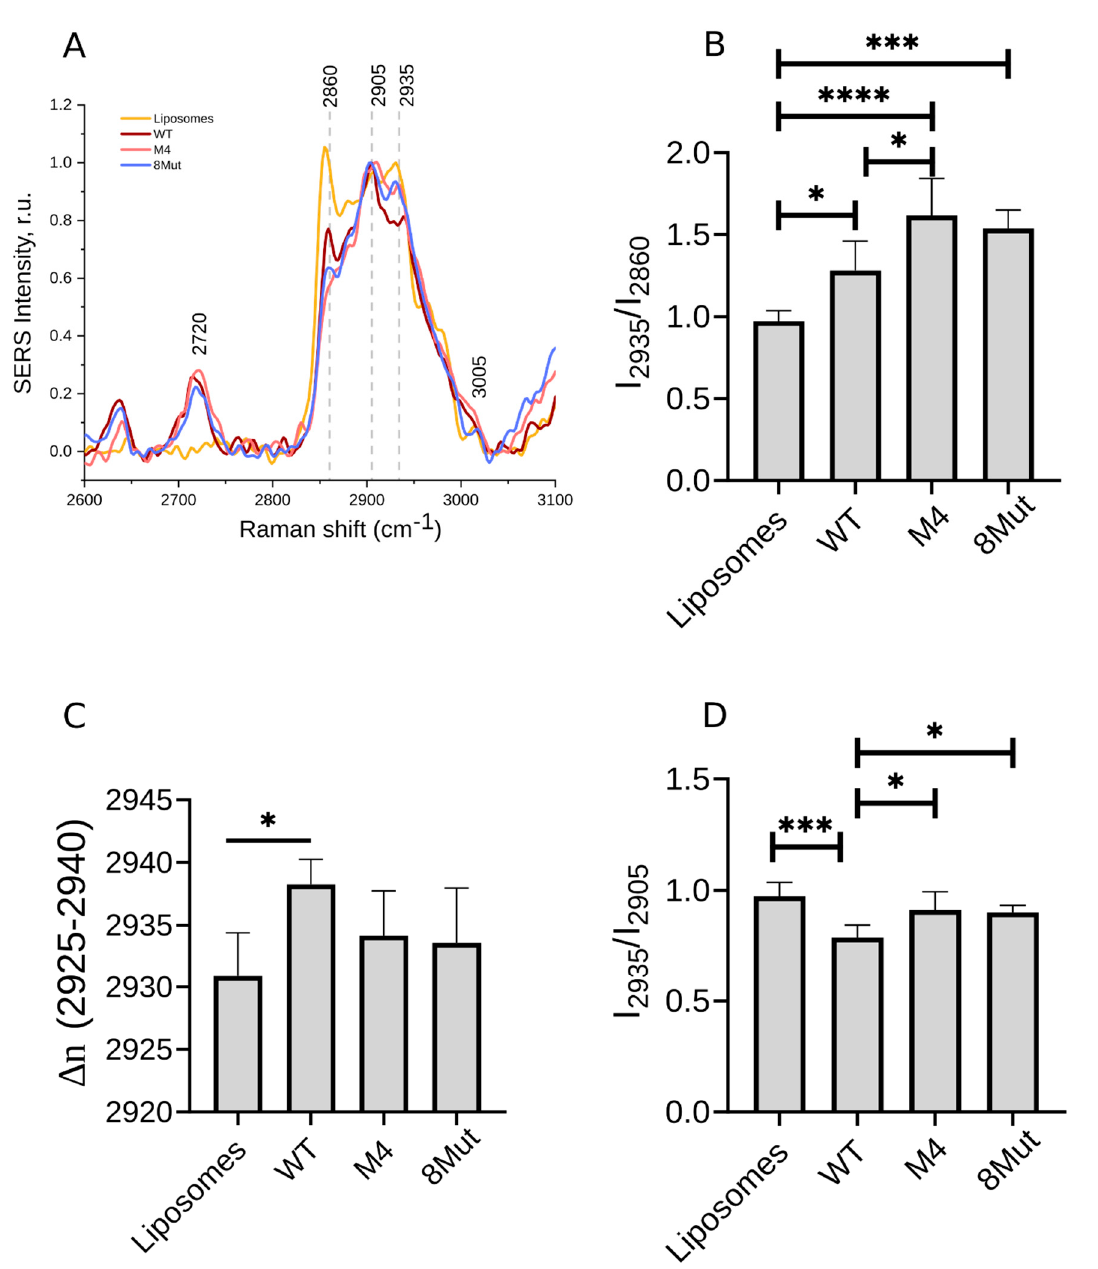
Figure 6. ( A ) Typical SERS spectra of control liposomes (PC:CL = 4:1) and liposomes with added cytochromes, normalized to the intensity of the peak 2905 cm − 1 . ( B ) The relative input of the symmetric vibrations of C − H bonds in CH 3 groups compared to the symmetric vibrations of − CH 2 − backbone bonds in the CytC protein part and in the acyl chains of liposomal lipids. ( C ) Maximum position of the peak corresponding to the symmetric vibrations of C − H bonds in side-chain CH 3 - groups. ( D ) The relative input of the symmetric vibrations of C − H bonds in − CH3 radicals compared to the asymmetric vibrations of − CH2 − backbone bonds. Data are presented as mean values and the error of the mean, n = 7. Statistics were calculated with ANOVA (GraphPad Prism 8.0). * p < 0.05, *** p < 0.001, **** p < 0.0001.